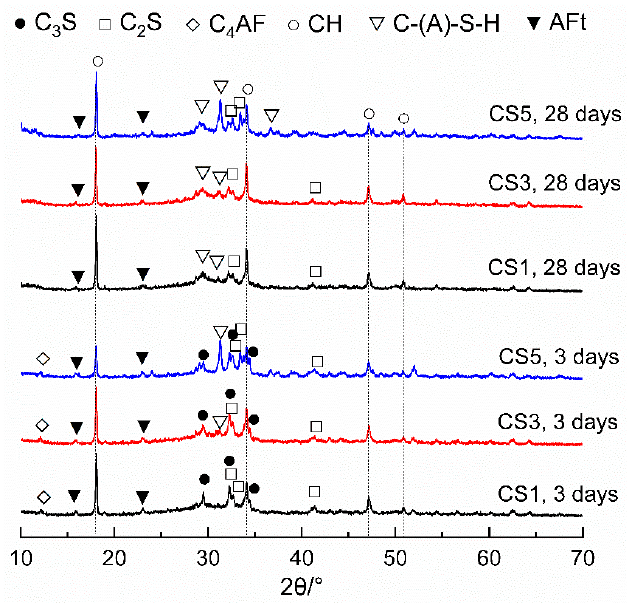
Figure 9. XRD patterns of slag pastes at 3 and 28 days. CH—portlandite, C-(A)-S-H—calcium silicate hydrate, AFt—ettringite.